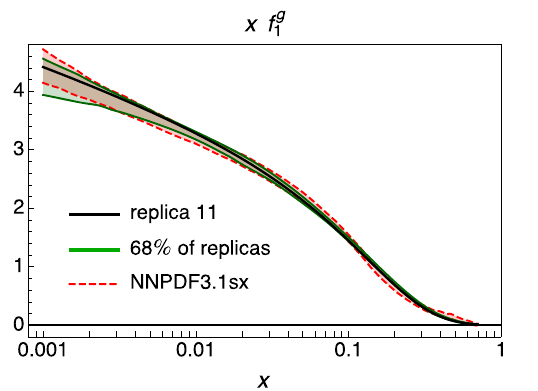
Fig. 3 The x f g (left panel) and xg g (right panel) as functions of x 1 1 at Q 0 = 1 . 64 GeV. Lighter band with red dashed borders for the NNPDF3.1sx parametrization of x f g [78] and the NNPDFpol1.1 1